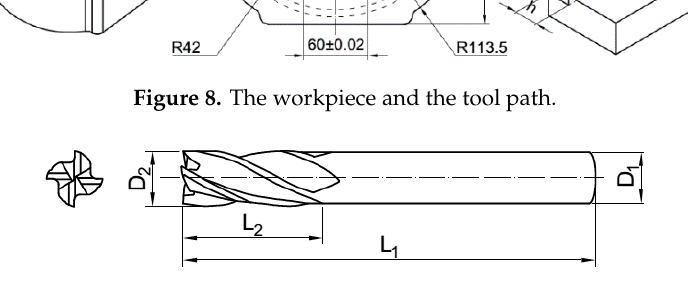
Figure 9. The end mill